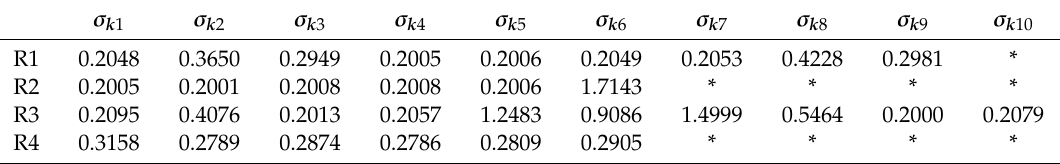
Table 3. Mach number membership σ ki ( H )